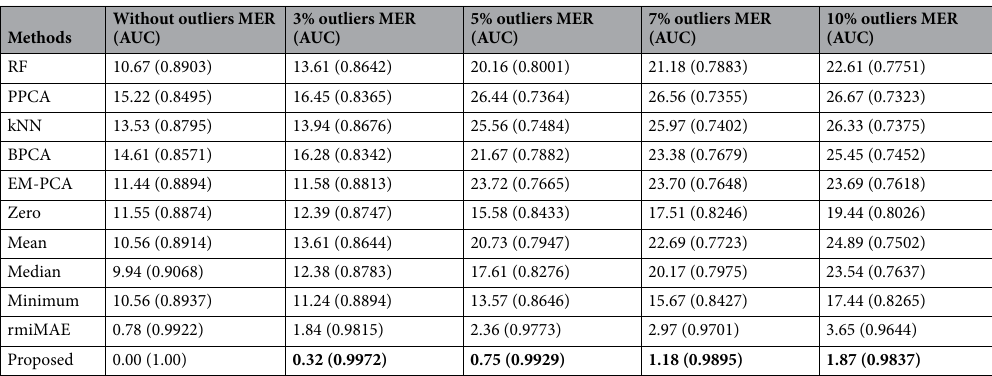
Table 4. Average misclassification error rate and area under the receiver operating characteristic curve (AUC) of sample classification for two class real dataset (hepatocellular carcinoma) with 26.52% missing values and artificially imputed different rates of outliers. Bold indicates the lower MER and Higher AUC throughout the